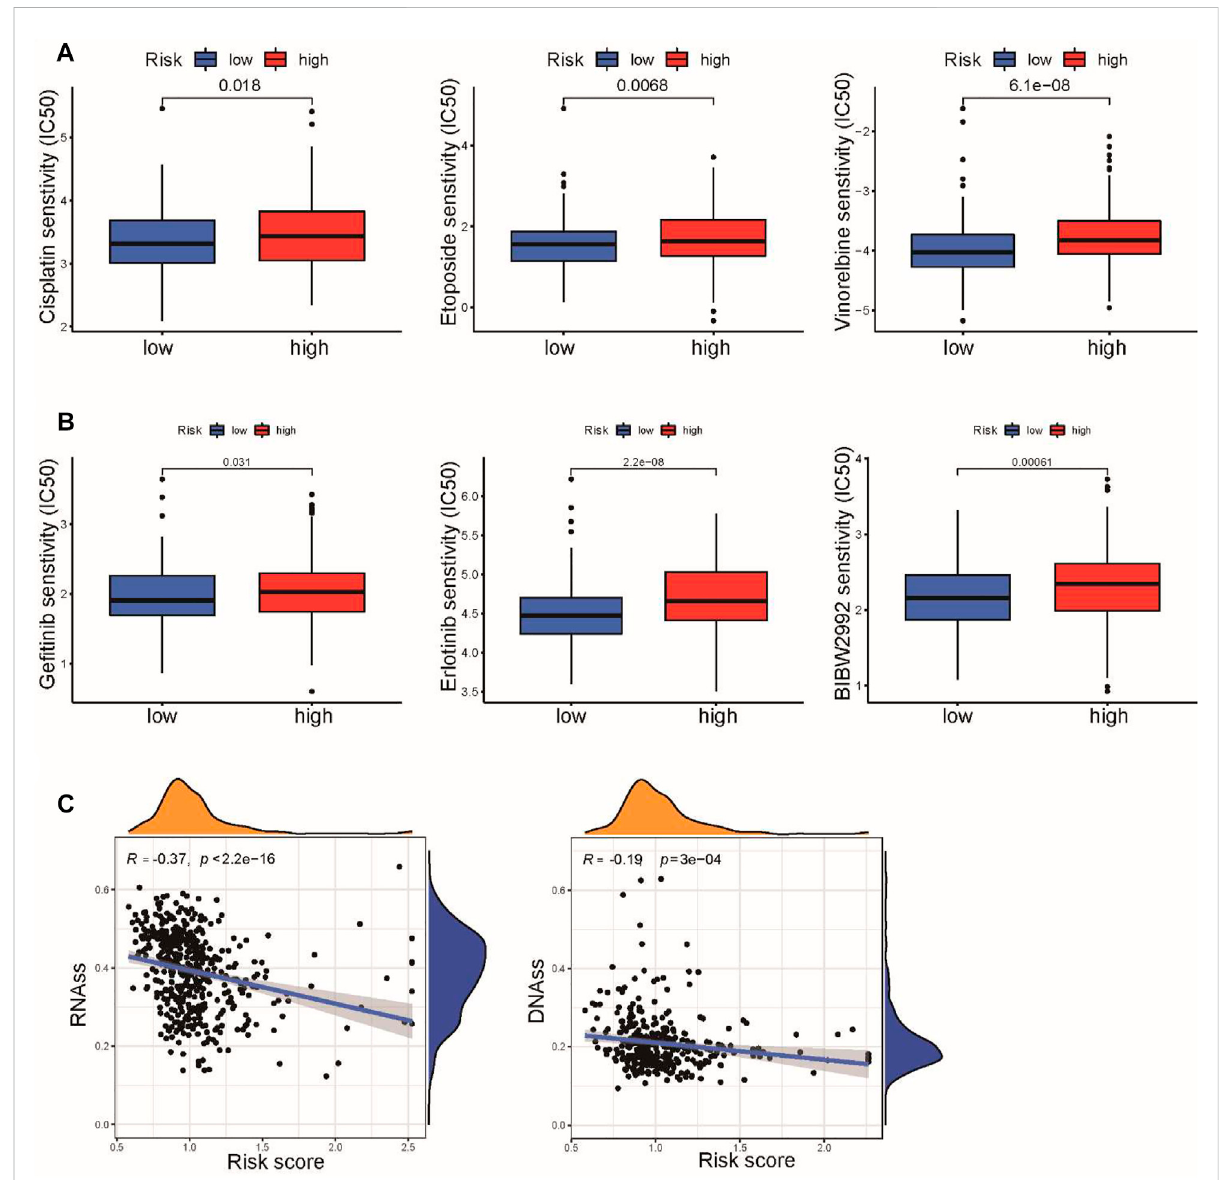
FIGURE 9 Association of risk score with chemotherapy and target therapy sensitivity in LUSC. (A) IC 50 values of three chemotherapeutic drugs, cisplatin, etoposide, and vinorelbine, were calculated based on the pRRophetic algorithm. (B) IC 50 values of three EGFR inhibitors, ge fi tinib, erlotinib, and afatinib, were calculated based on the pRRophetic algorithm. (C) Correlation between the risk score and cancer stemness scores of RNAss and